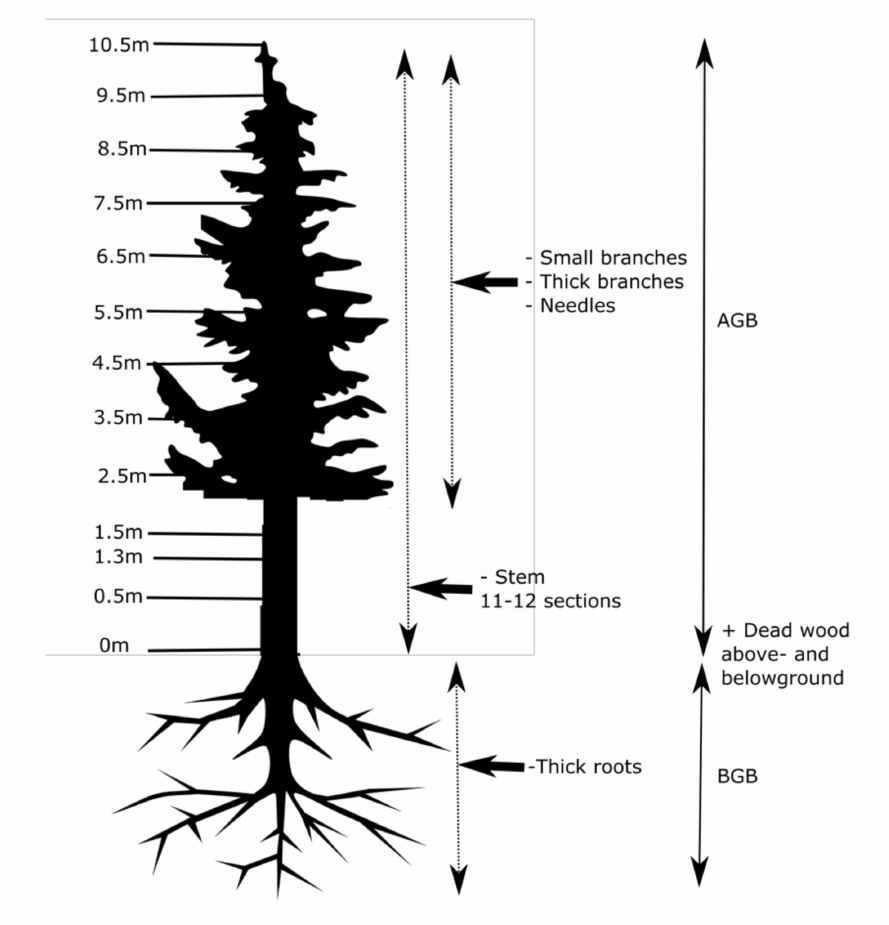
Figure 2. Scheme of tree components used for in situ biomass investigation of five model trees collected from the main research area. AGB–Above Ground Biomass, BGB–Below Ground